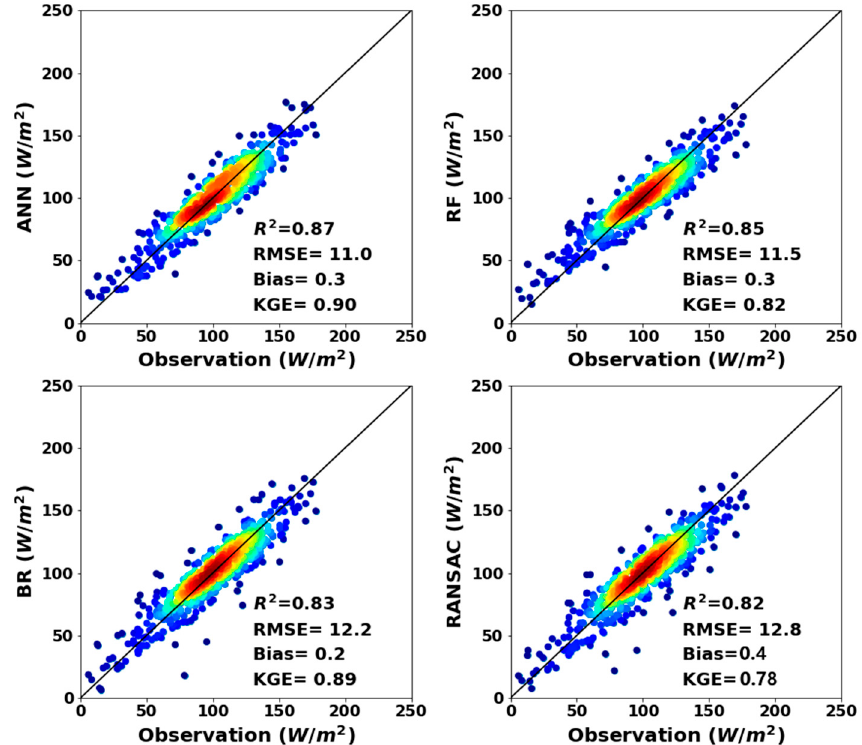
Figure 6. The scatter plot for ocean LHF observations from 34 validation buoy sites and the LHF estimations from the ANN , RF , BR and RANSAC methods during 2003–2007 (unit W m − 2 ).